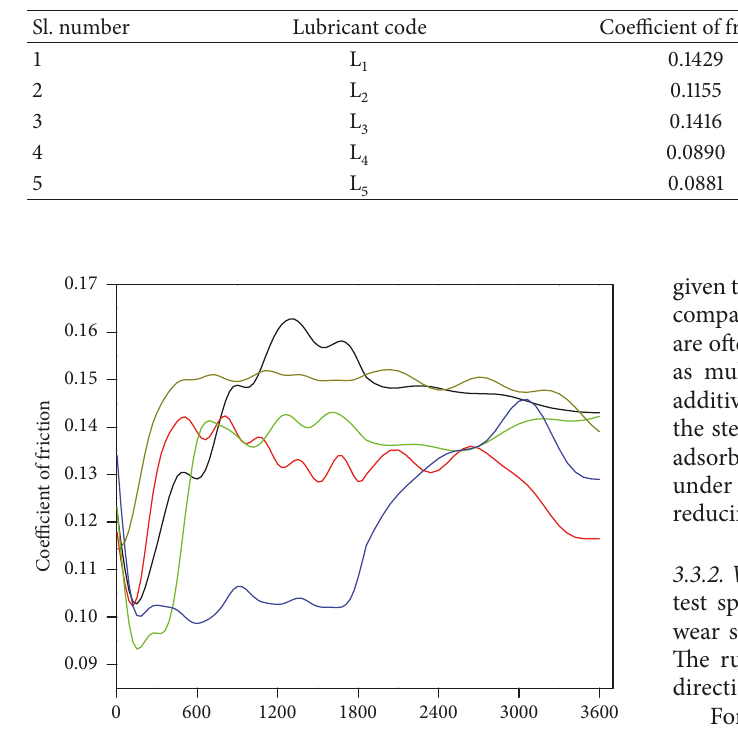
Table 6: Tribological performance of lubricants.